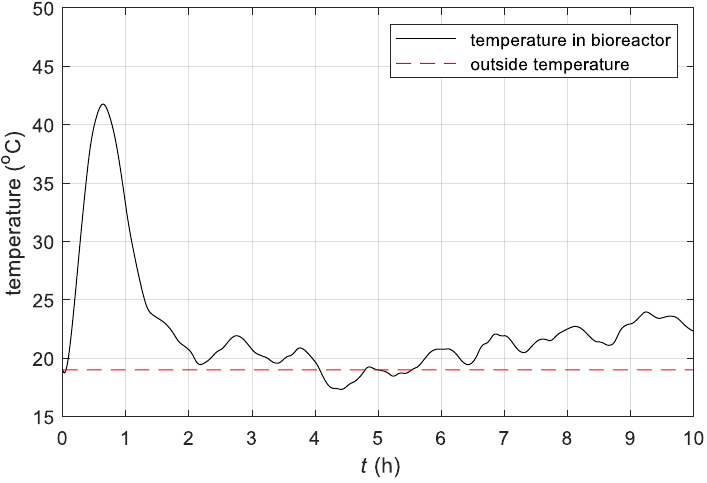
Figure 7. Time response of the temperature of the original fermentation process in the batch bioreactor and the constant outside temperature, corresponding to Figure 6.